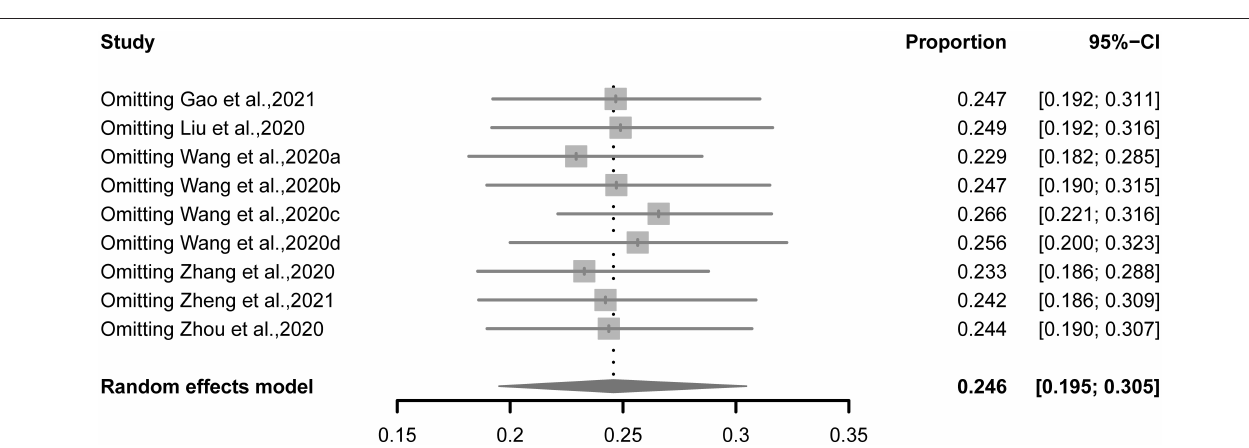
FIGURE 4 | Sensitivity analysis of the pooled estimate of prevalence in this meta-analysis.